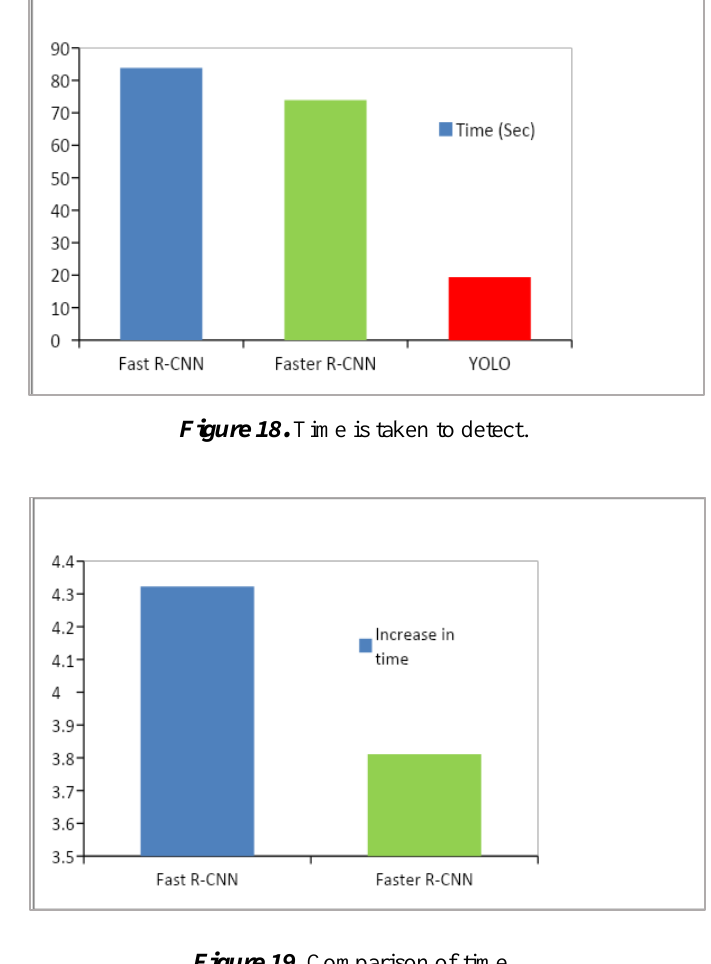
Figure 19. Comparison of